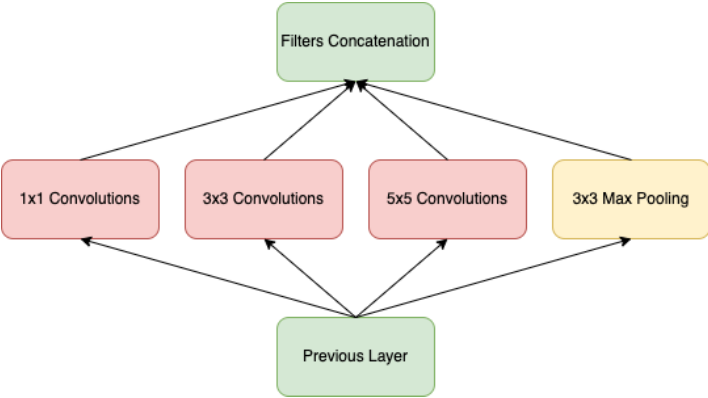
Figure 7. Naive Inception module.